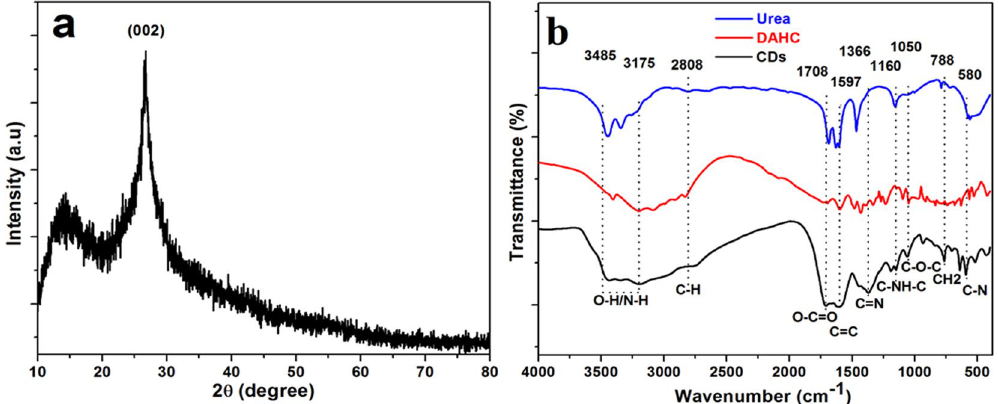
Figure 3. ( a ) The XRD profile of the prepared green-emitting CDs. ( b ) FT-IR spectrum of Urea, diammonium hydrogen citrate (DAHC) and obtained green-emitting CDs.